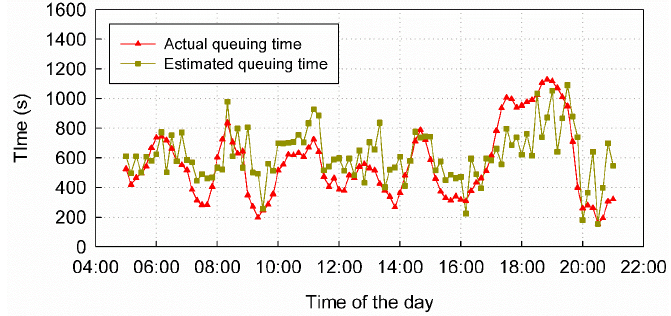
Figure 6. Validation results of the WiFi-based estimation model.